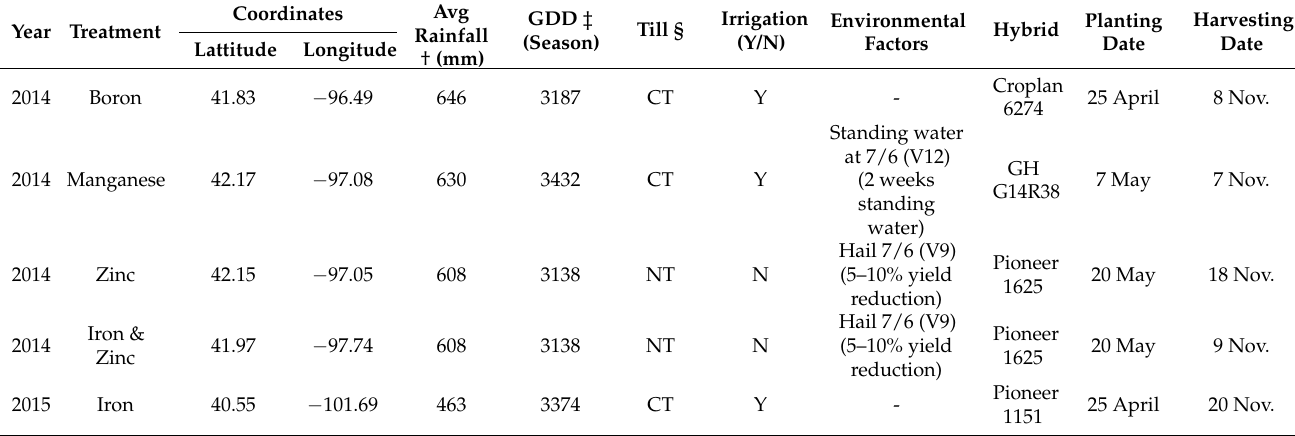
Figure 1. Locations of field experiments Table 1. Background information and cultural practices for the five foliar micronutrient experimental locations.